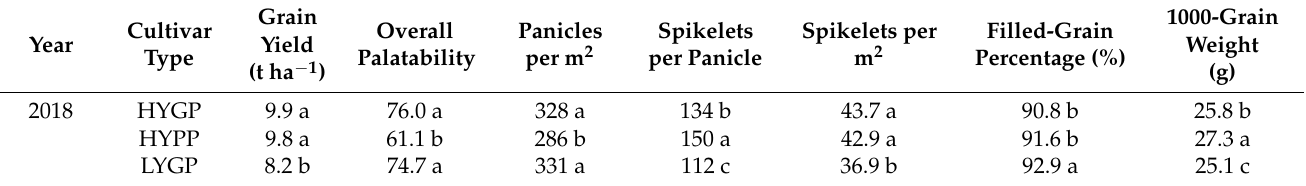
Table 2. Grain yield, overall palatability, and yield components of rice cultivar